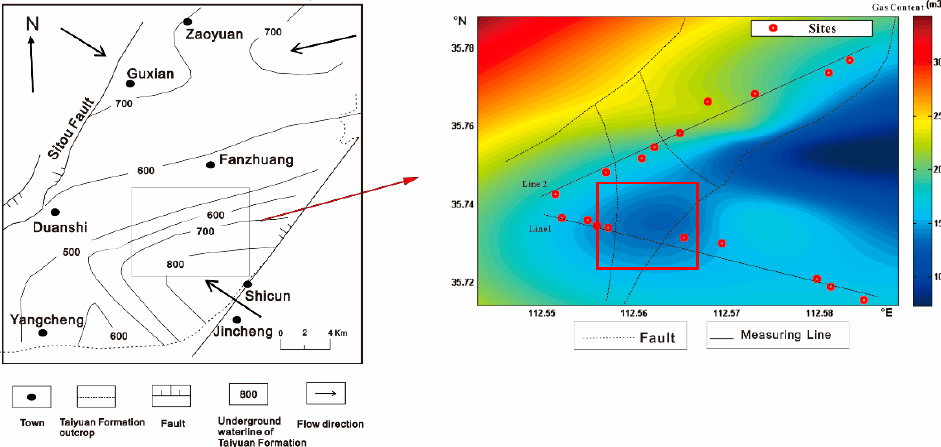
Figure 14. The geological map of the study area and the distribution map of the gas content in the No. 3 coal reservoir in the study area and the location of the measuring sites. Note: The red dots represent the field experiment points, and the black lines represent two noticeable measurement lines. The two points framed in a red rectangle are the positions of coalbed methane (CBM) wells. The point on the left is Well 01, representing Well 1-4; the point on the right is Well 02, representing Well 1-5.